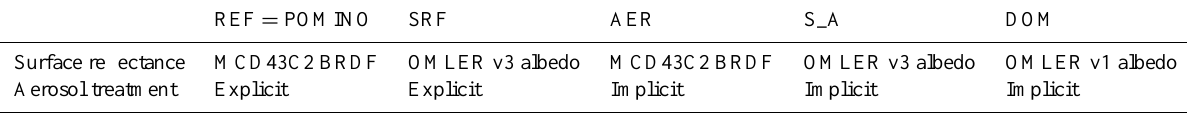
Table 2. Retrievals of clouds and NO 2 with different approaches ∗ . REF = POMINO SRF AER S_A DOM Surface reflectance MCD43C2 BRDF OMLER v3 albedo MCD43C2 BRDF OMLER v3 albedo OMLER v1 albedo Aerosol treatment Explicit Explicit Implicit Implicit